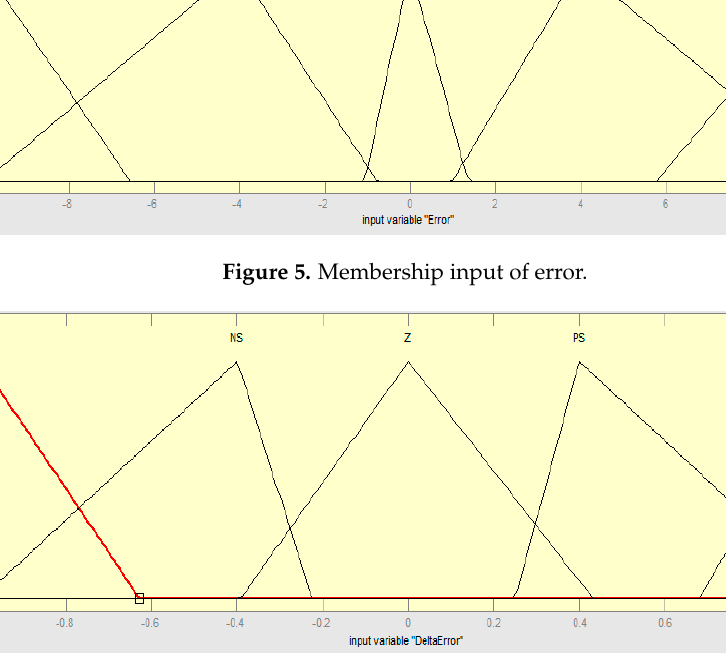
Figure 5. Membership input of error.